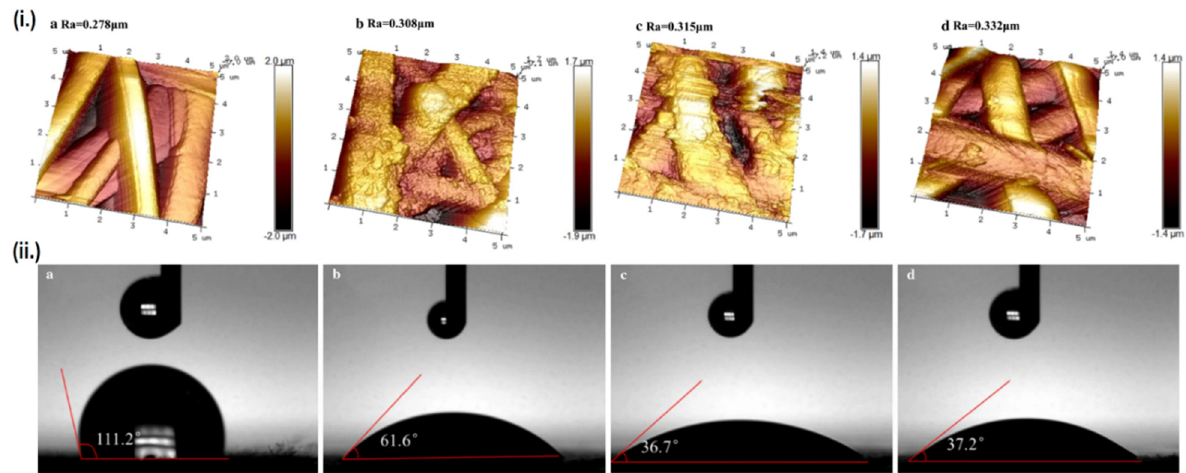
Figure 4. Relationship between surface roughness and hydrophilicity. ( i. ) AFM images and surface roughness value (Ra) of the scaffolds, and ( ii. ) Contact angle of each scaffold. Each alphabet corresponds to different samples, namely: ( a ) PLA, ( b ) PANI/PLA-HCl, ( c ) PANI/PLA-H 2 SO 4 , and ( d ) PANI/PLA-HClO 4 . Adapted with permission from [92]. Copyright (2021) Springer.